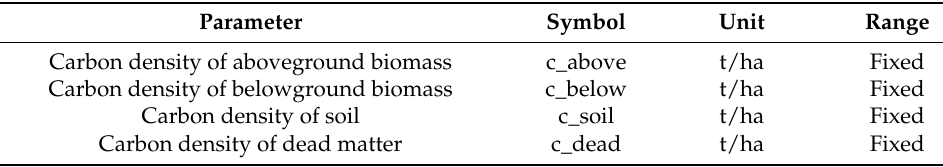
Table 11. Carbon Storage and Sequestration model parameters.